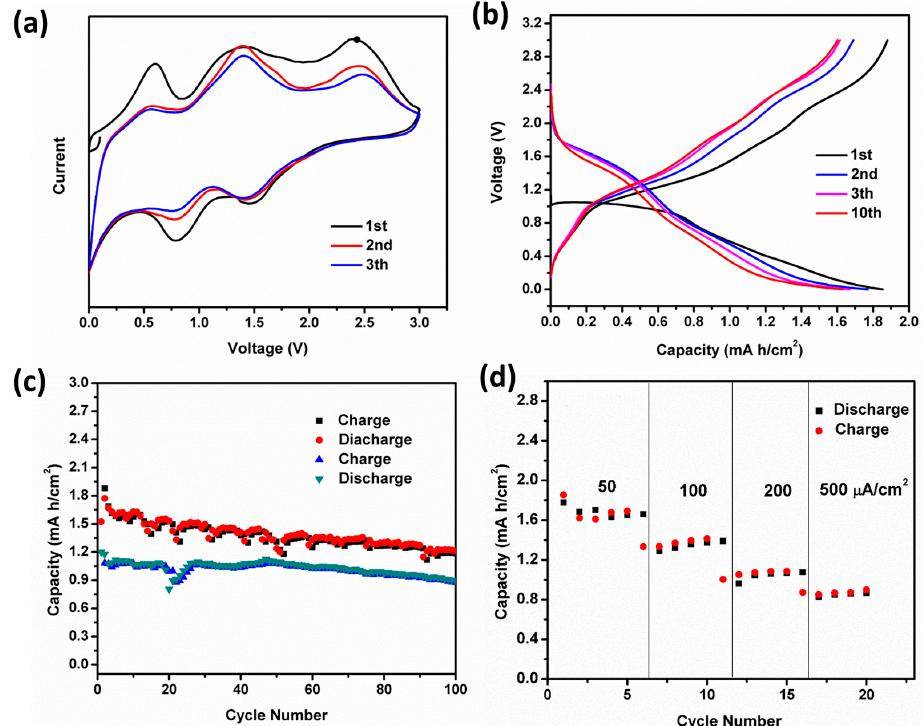
Figure 4. ( a ) Representative cyclic voltammetry (CV) curves of Ni 2 GeO 4 porous nanosheets for the fi rst 3 cycles at a scan rate of 0.5 mV·s − 1 between 0.01 V and 3 V; ( b ) Voltage pro fi les of Ni 2 GeO 4 porous